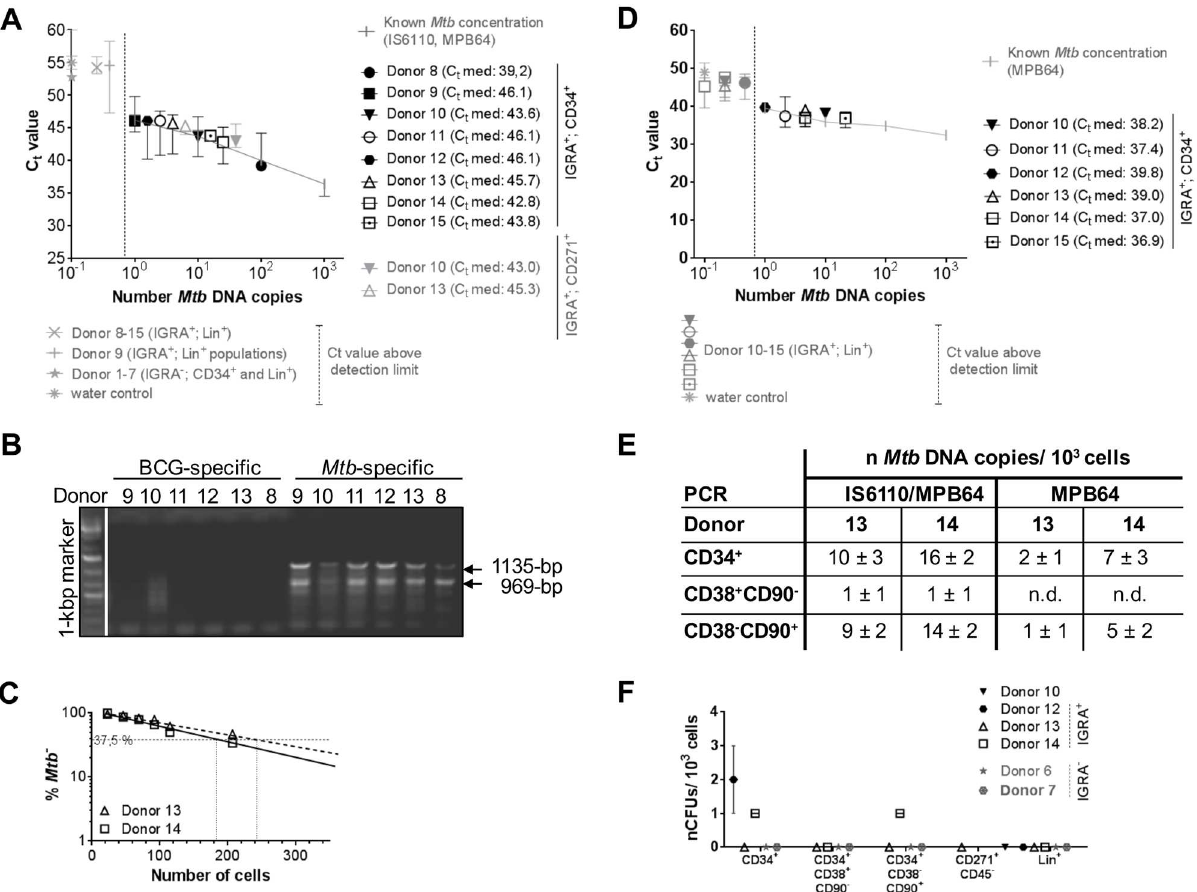
Fig 1. Human peripheral Lin – CD34 + , Lin – CD34 + CD38 low CD90 + , SP + pHSCs as well as CD271 + CD45 - MSCs of IGRA + donors harbour Mtb DNA. Lin + , Lin – CD34 + , Lin – CD34 + CD38 low CD90 + , Lin – CD34 + CD38 + CD90 – , Lin – SP + and Lin + SP − cells (Donors 1, 6, 8, 9) were purified from blood of IGRA + (n = 8) and IGRA − donors (n = 7; S1A Fig). CD271 + CD45 - MSCs (Donors10 and 13) were purifiedfrom blood of IGRA + donors (n = 2; S1B Fig). CD1c + , CD14 + , CD16 + , CD4 + /8 + , CD15 + , CD19 + , and CD56 + cells were preparedfrom blood of IGRA + donors (n = 3). Genomic DNA preparedfrom 10 3 hematopoietic progenitors and MSCs as well as 10 5 Lin + cells from IGRA + and IGRA - donors were tested for the presence of Mtb DNA by PCR. (A, E) Quantification of Mtb -specificDNA by real-time TaqMan PCR using probes that target MPB64 and IS6110 together(S4 Fig). (B) Genomic DNA of 10 3 hematopoietic progenitors from IGRA + and IGRA - donors were tested by PCR for a DNA fragment present in Mtb , but not in BCG. (C) Quantificationof Mtb -specific DNA by limiting dilutionsusing a single-target PCR for IS6110 (Donor 13, 14; S2A Fig). (D, E) Quantification of Mtb -specificDNA by real-time SYBR green PCR using primers that target MPB64 alone (S4 Fig). Real-timePCRs were performed in 2 independent runs in technicaltriplicatesand normalizedto human GAPDH. Known Mtb concentrations were used as reference. (F) CFU Mtb growth on Middlebrook7H11 agar plates (n = 2–3). Data are shown as median +